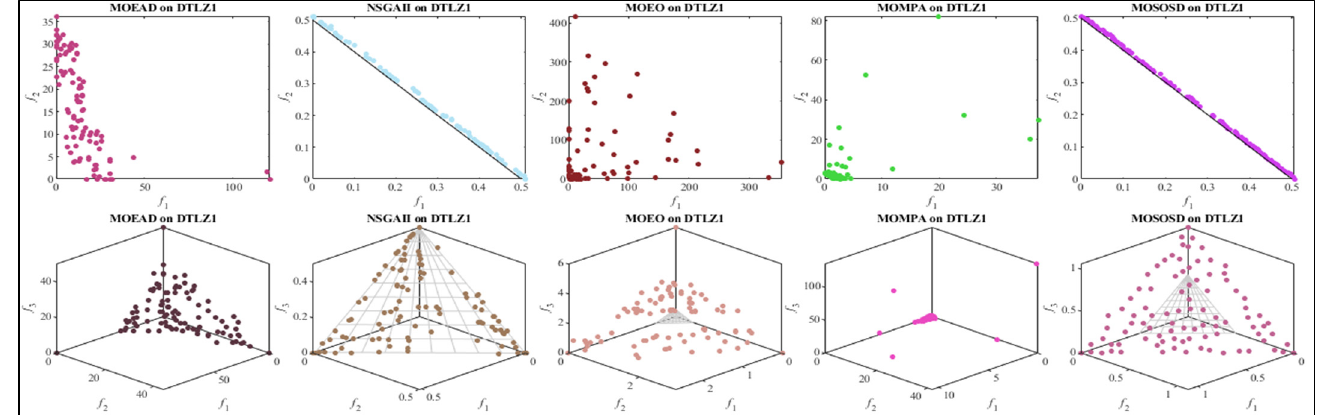
Figure 2. The Pareto front for DTLZ1 using various algorithms at 𝑀 = 2, 3 .